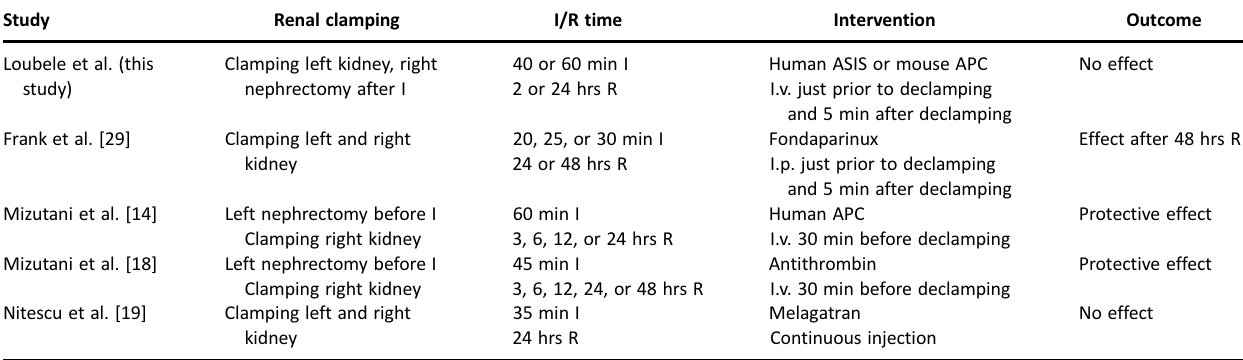
Table 1. Overview of distinct studies on renal I/R injury with anticoagulant intervention.